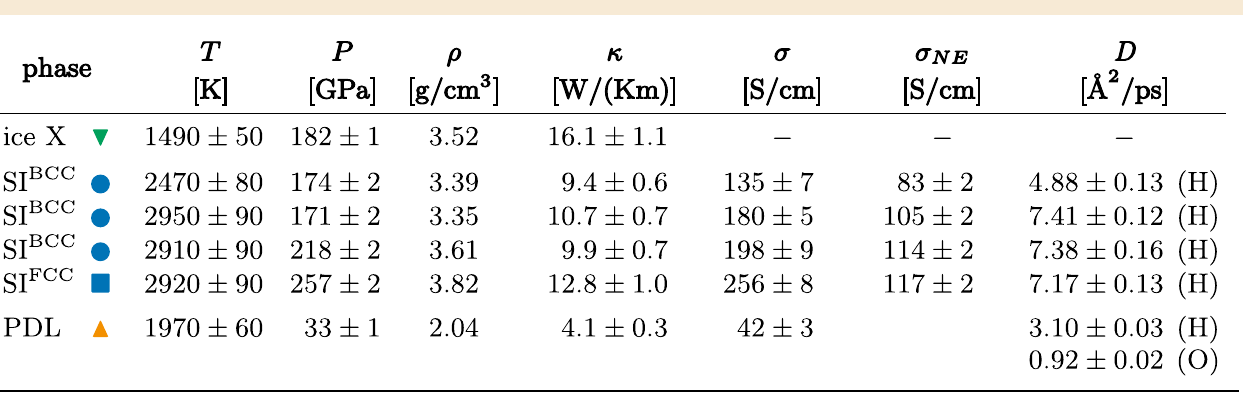
Table 1 Summary of our results.